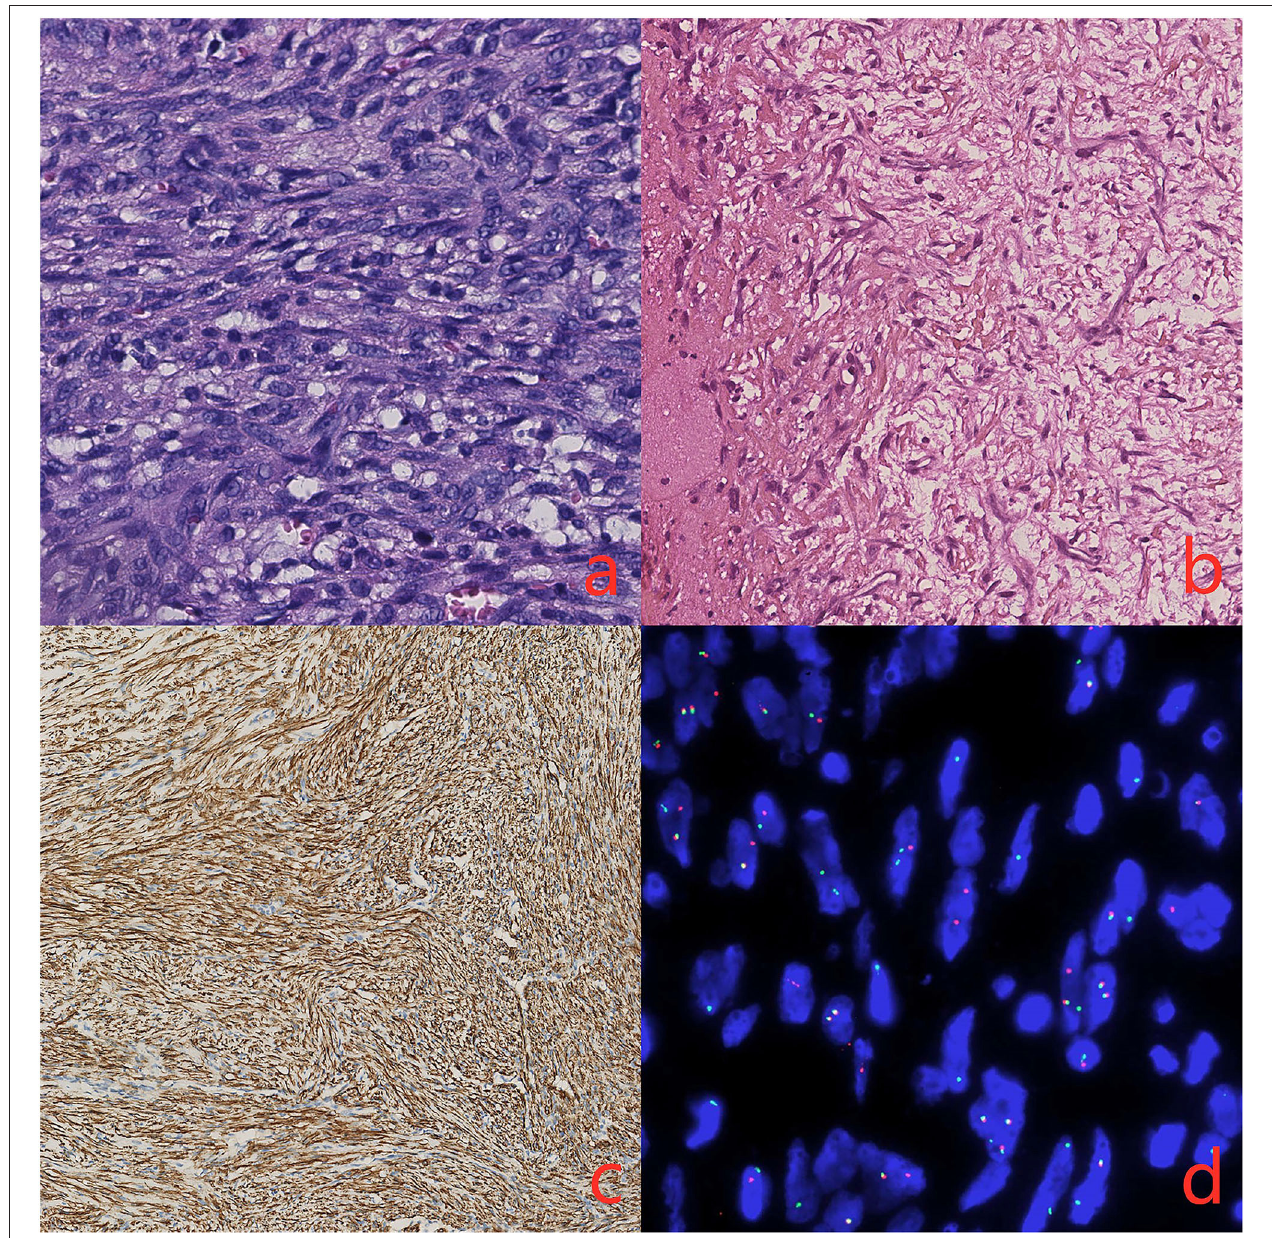
FIGURE 3 | (a) There is a proliferation of spindle cells arranged in intersecting fascicles (hematoxylin and eosin, original magnification 40x) (b) . The immunohistochemical stains demonstrated elastin stains was negative (original magnification 20x) (c) . The spindle cells are diffusely positive for smooth muscle actin (SMA, original magnification 20x) (d) . FISH showing rearrangement of the USP6 locus (separation of green and red signals).